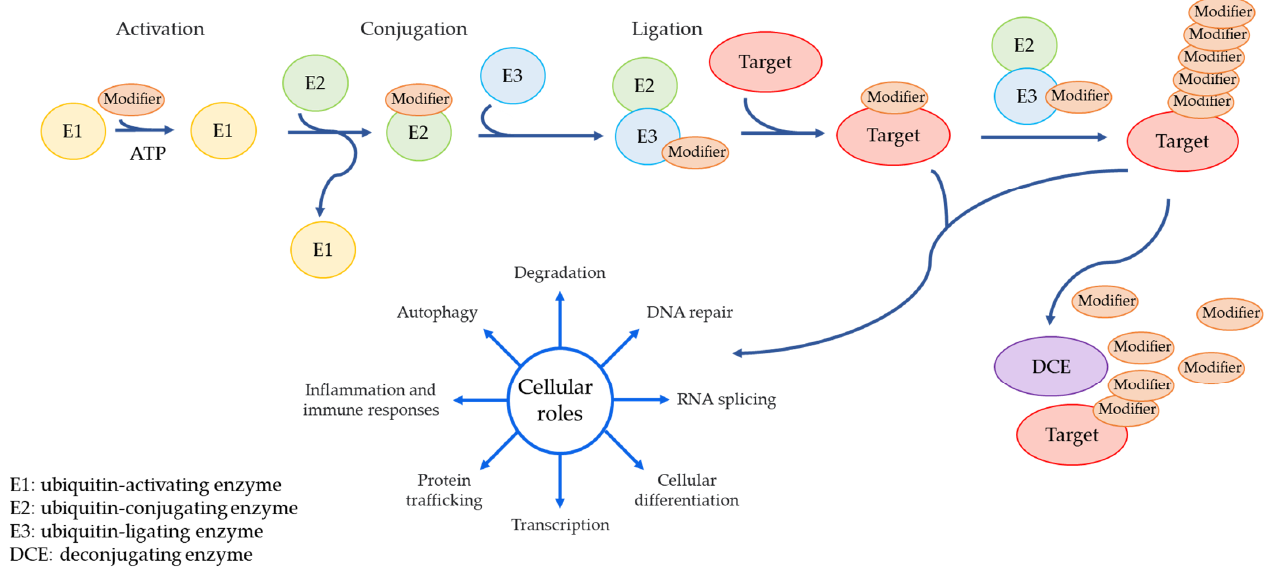
Figure 1. An enzymatic cascade of Ub and Ubls, and deconjugating enzymes. Ub and Ubls are conjugated to target substrates by an enzymatic cascade involving E1, E2, and E3. A modifier is first activated by an E1 activating enzyme and is transferred onto an E2 conjugating enzyme. Subsequently, E3 ligase interacts simultaneously with a modifier-loaded E2 and the target protein, and induces an isopeptide bond between the C-terminus of modifier and a lysine residue of the substrate. Once a modifier is conjugated to their targets, polypeptide chains are formed due to the presence of suitable motifs on modifiers. Deconjugating enzymes are responsible for the reverse process of the modification.